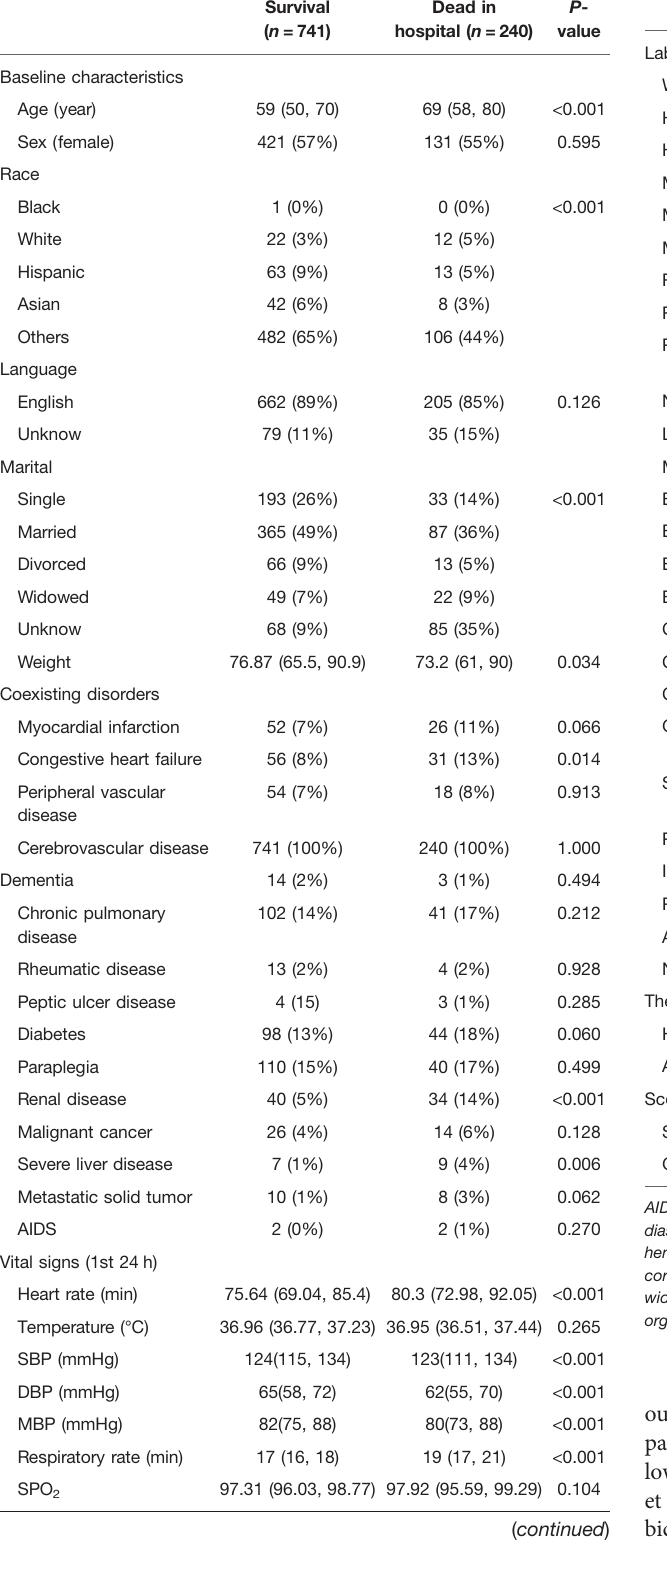
TABLE 5 | Baseline characteristics of patients without traumatic subarachnoid hemorrhage.